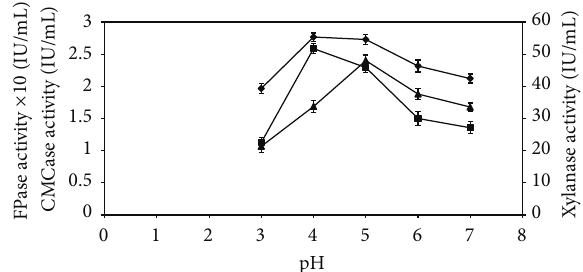
Figure 2: Effect of incubation period on CMCase, FPase, and xylanase activities. Results are presented as the mean of three replicates with standard deviation: ( Q ) FPase; ( ◼ ) CMCase; ( 󳵳 ) xylanase.